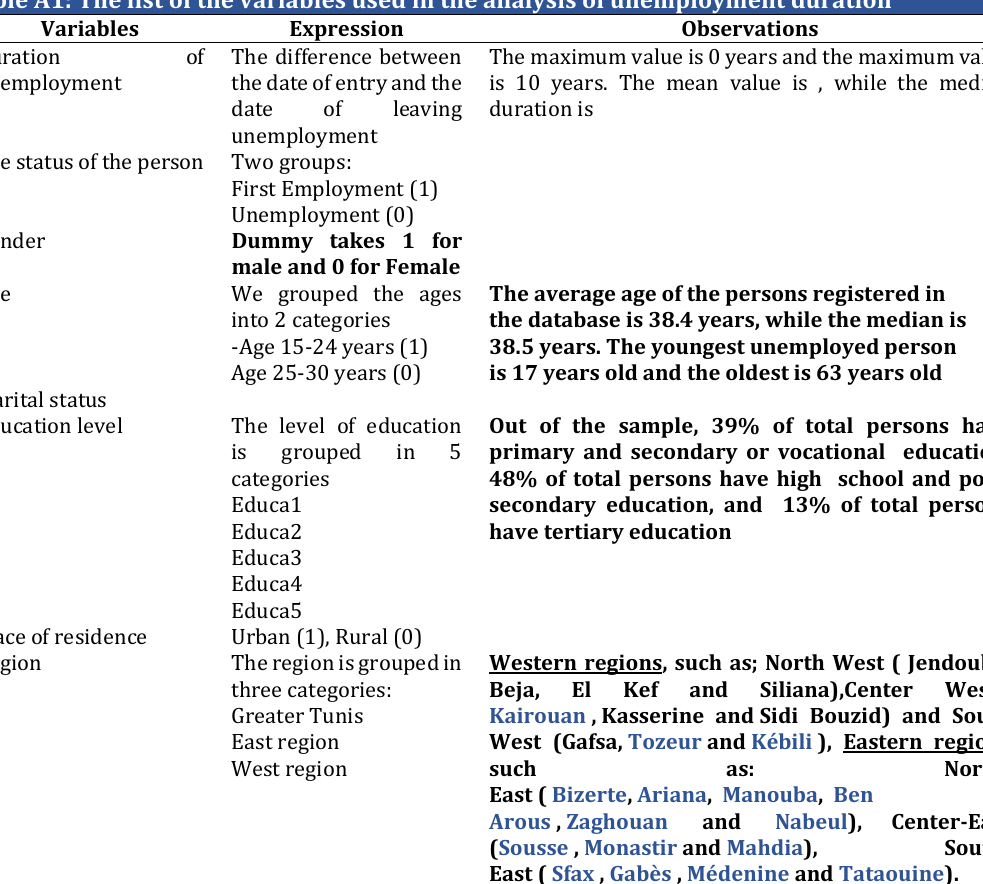
Table A1: The list of the variables used in the analysis of unemployment